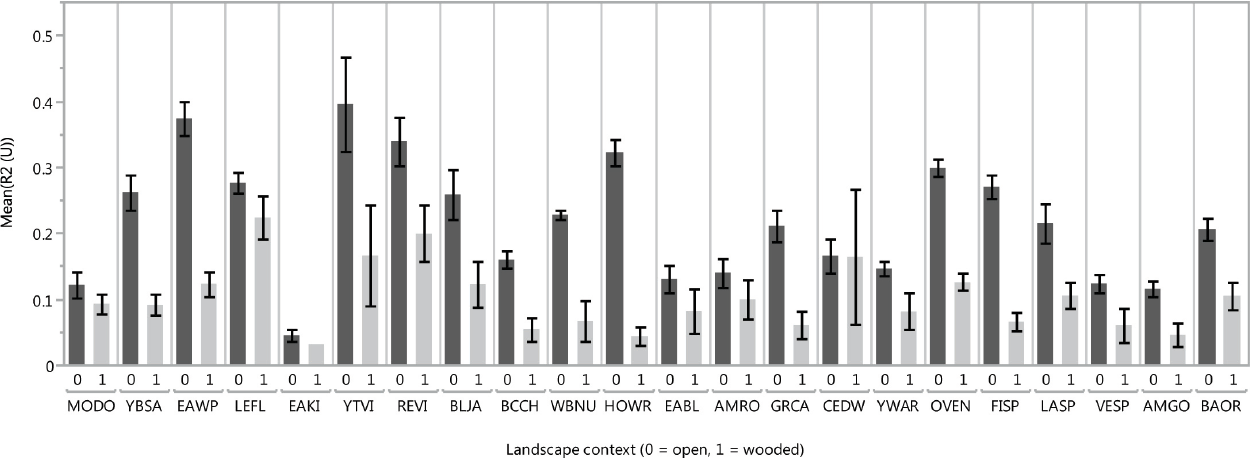
Fig. 3 . Comparison of regression results in open and wooded landscapes. In all cases, the predictor variable was percentage tree cover within 100 m, and the response variable was likelihood of occurrence for a given species. Bars represent the mean of regression coefficients of determination for 10 groups of observations in open landscapes and 10 in wooded landscapes. Error bars represent 1 standard error from the mean. Open landscapes were defined as having < 30% tree cover within 400 m; wooded landscapes had > 30% tree cover. For species codes, see Table